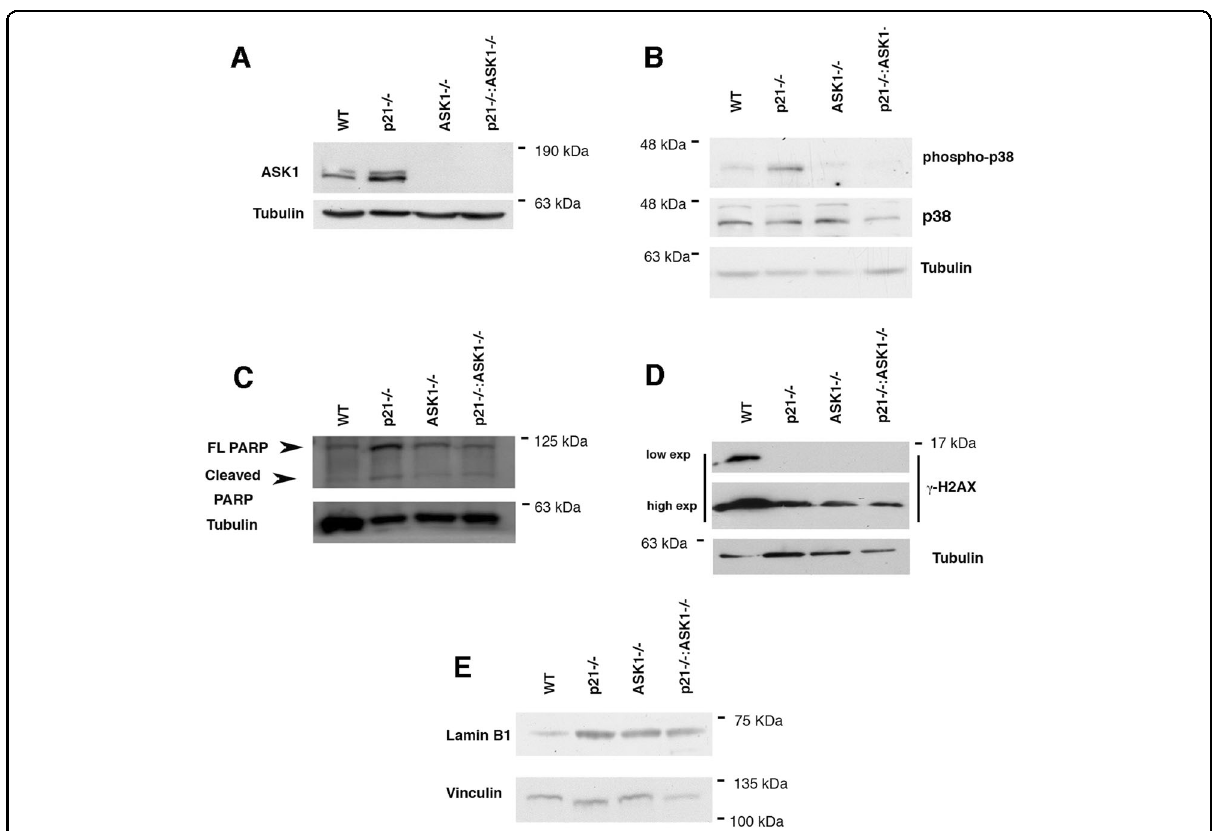
Fig. 3 ASK1-p38 axis promotes apoptosis in p21-de fi cient primary keratinocytes. A – E Primary mouse keratinocytes were established from 2- day-old newborn mice and maintained in low calcium medium. Cells were analyzed 5 days post-seeding by western blot analysis with the indicated